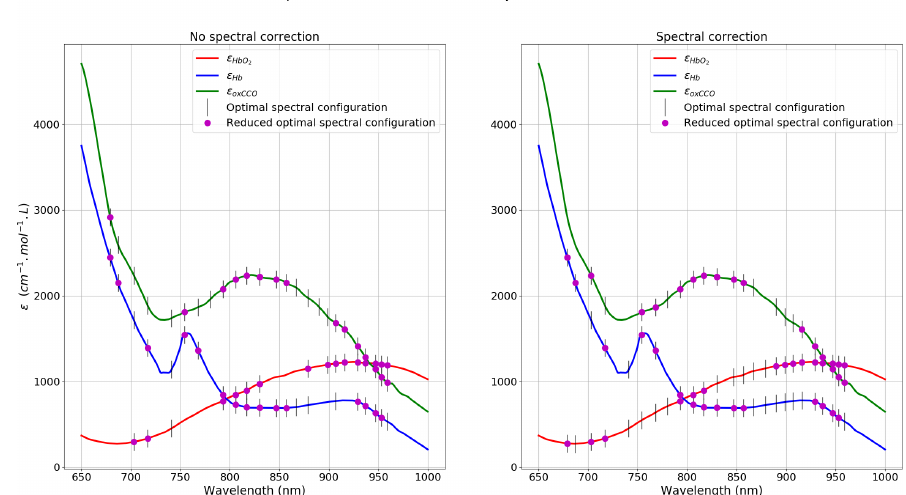
Figure 7. Optimal spectral configuration of the hyperspectral camera XIMEA MQ022HG-IM-SM5X5- NIR obtained with the simulation-based method. The peaks of the selected spectral bands are represented as vertical lines in the molar extinction coefficients of the deconvolved chromophores. The reduced optimal spectral bands are indicated by violet points in the molar extinction coefficients of the deconvolved